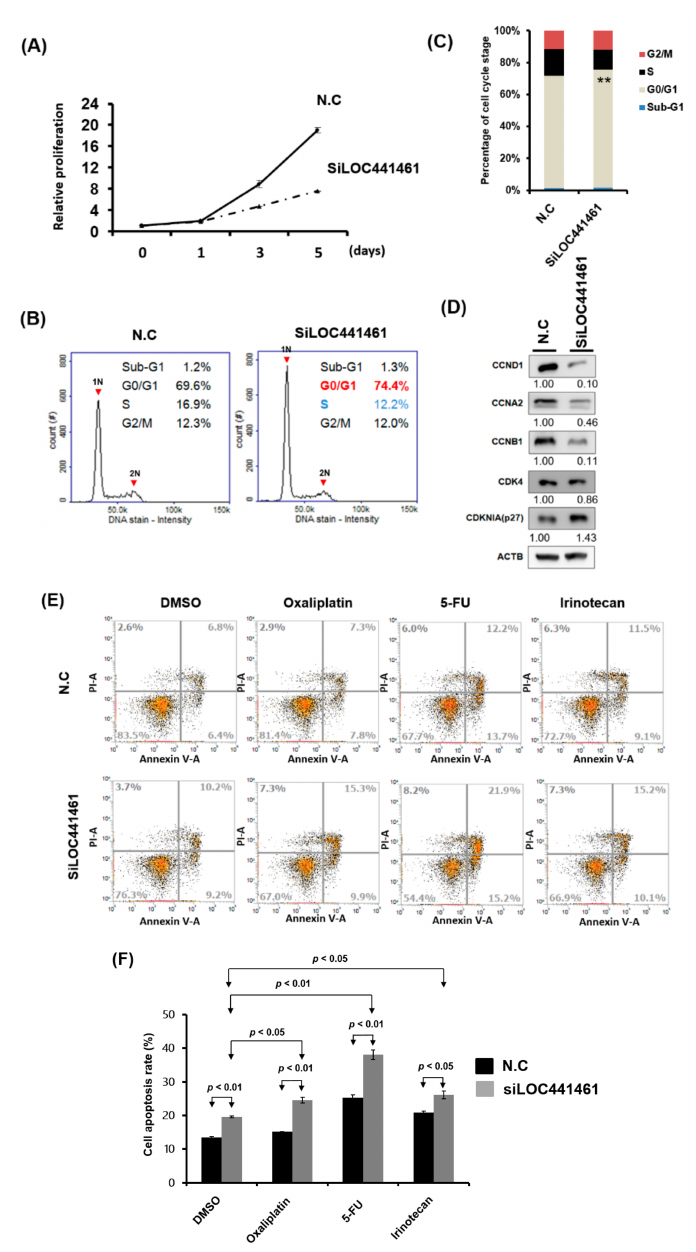
Figure 4. LOC441461 knockdown suppressed SW620 cell proliferation by inducing cell cycle arrest and apoptosis. ( A ) LOC441461 expression levels were knocked down with si-LOC441461 transfection in SW620 cells. Cell proliferation compared with the scrambled control was measured using the CellTiter-Glo One Solution assay at various time points (0, 1, 3, and 5 days). ( B ) Distribution of cells in three phases of the cell cycle was examined using the image flow cytometry assay. ( C ) Graph of each quantified phase. ( D ) Cell-cycle-related protein levels were examined using the Western blotting assay in SW620 cells with and without LOC441461 knockdown. ( E , F ) After exposure to 2 µ g / mL oxaliplatin, 5-FU, or irinotecan for 48 h, cell apoptosis was examined using Annexin V assay, and the percentage of apoptosis was quantified in colon cancer cells with LOC441461 knockdown and in control cells. All the experiments were performed in triplicate, and these data were analyzed using Student’s t test. The di ff erence was considered significant when p < 0.05. ** Indicates di ff erence that is considered significant between the indicated groups p <